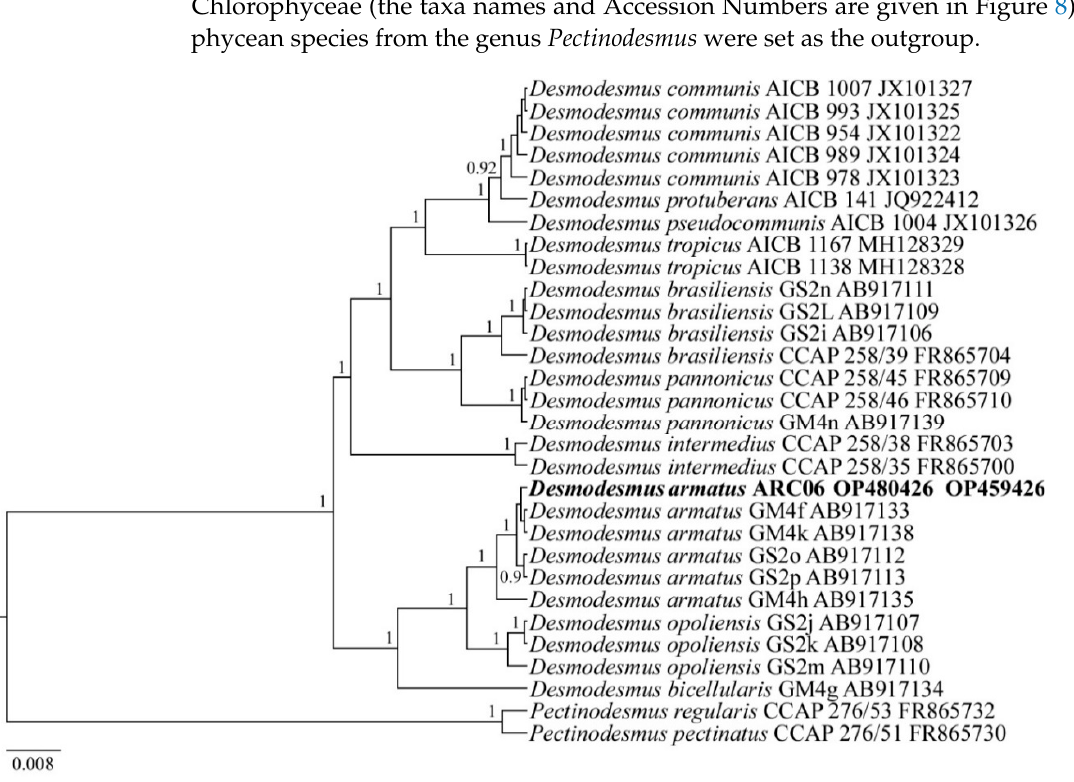
Figure 8. Phylogenetic position of the strain Desmodesmus armatus ARC06 (indicated in bold) based on Bayesian inference for the partial 18S rRNA gene and ITS1–5.8S rDNA–ITS2 region. Total length of the alignment is 2132 characters. Posterior probabilities exceeding 0.9 of BI (constructed by Beast) are presented in order on the nodes. Strain numbers (if available) and GenBank numbers are indicated for all sequences.